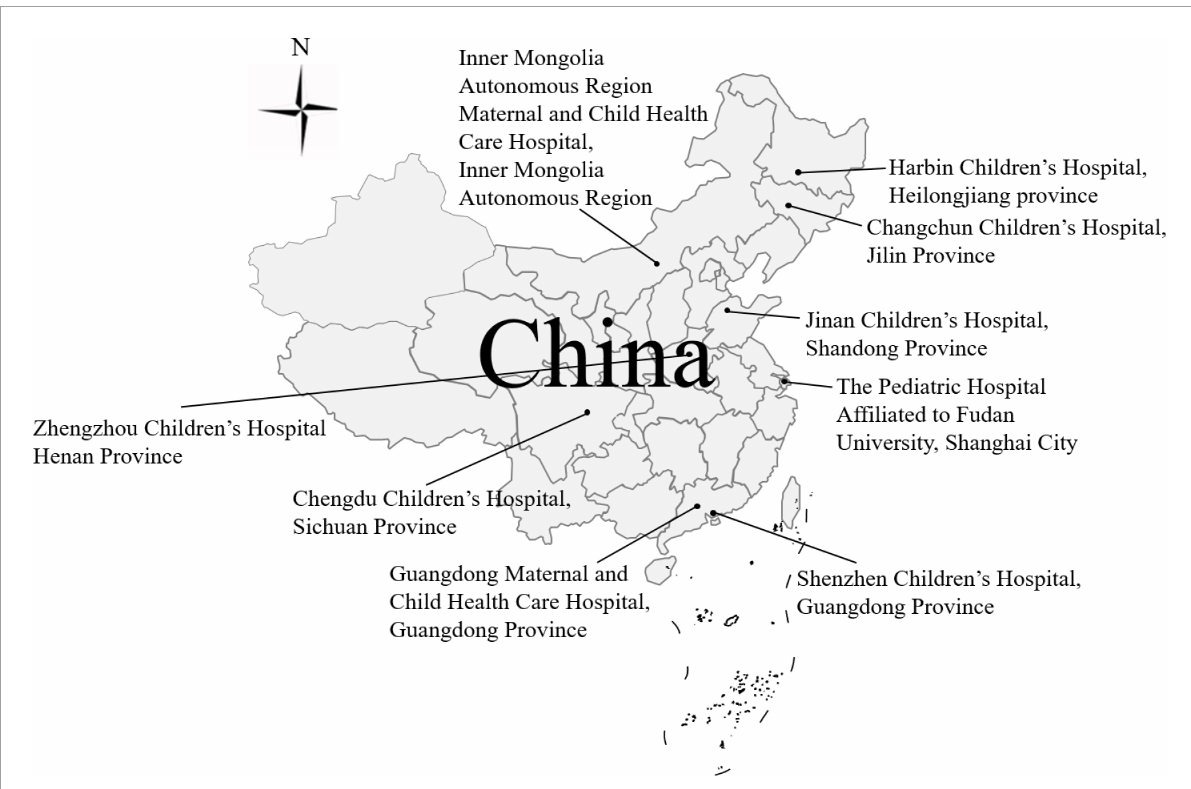
FIGURE1 The 115 dominant G9P[8] RVA strains collected from eight sentinel hospitals in seven provinces in China from 2016 to